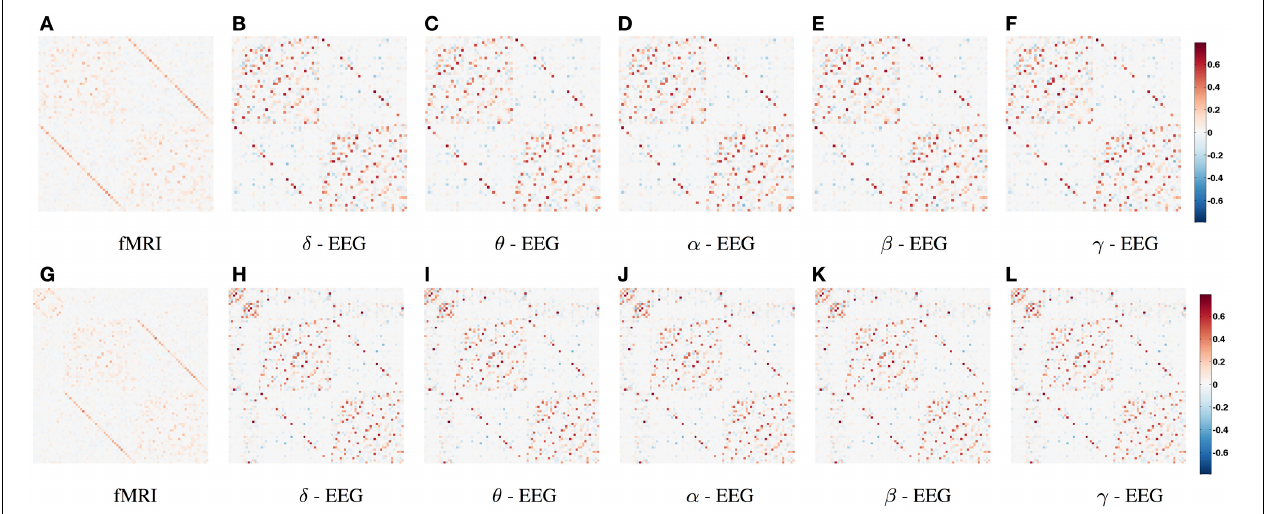
are ordered similarly in their matrix representation). For the cortical regions, the top left matrix quadrant represents connections within left hemisphere (lh), the bottom right represent connections within the right hemisphere (rh), and the remaining quadrants represent inter-hemispheric connections. At (G–L) , the subcortical regions have been added at the top left corner of the connectivity